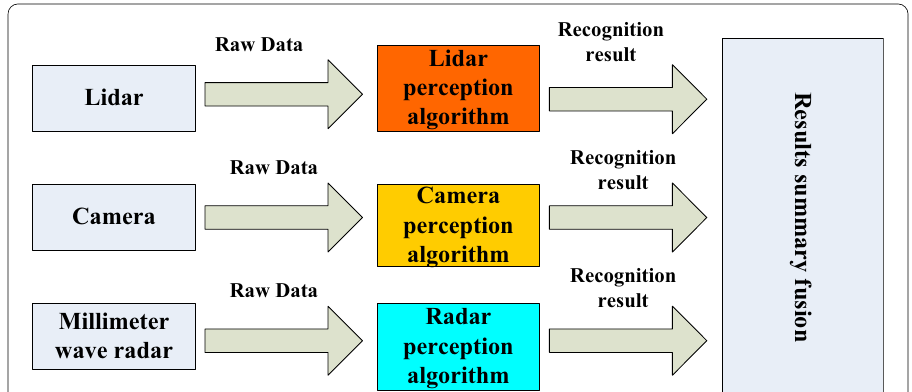
Fig. 2 Typical structure of post-fusion